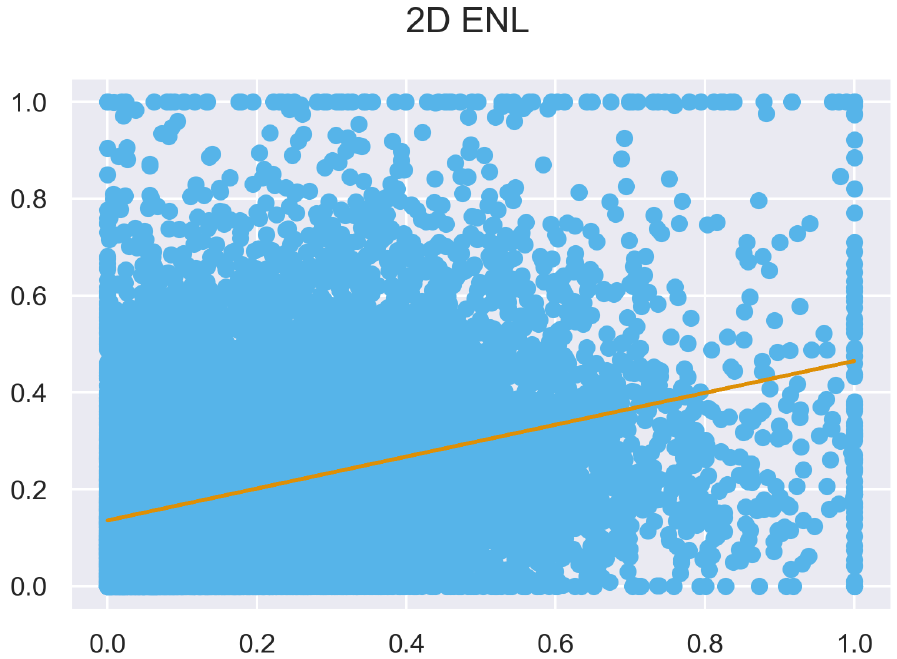
Figure A6. ULS and TLS 2 D ENL regression at 0.5 m grid